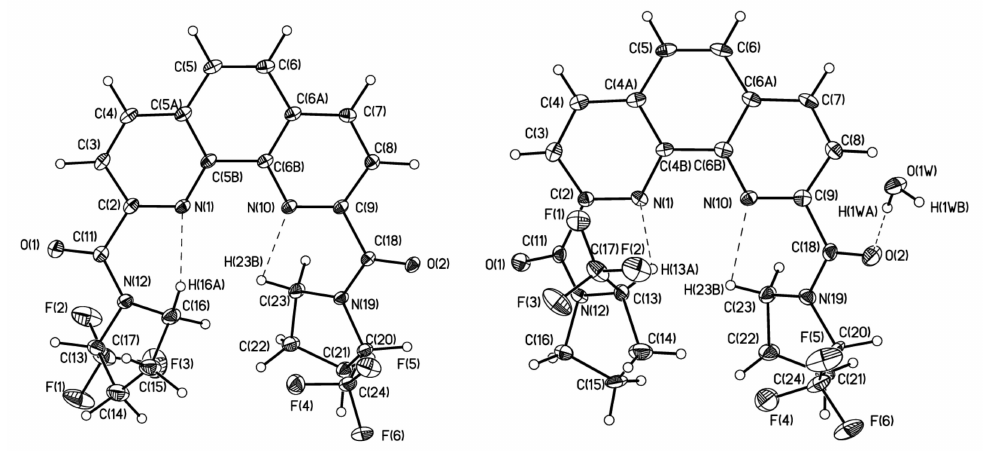
Figure 4. The general view of (left) 1A and (right) 1B · H 2 O in representation of atoms by thermal ellipsoids ( p =